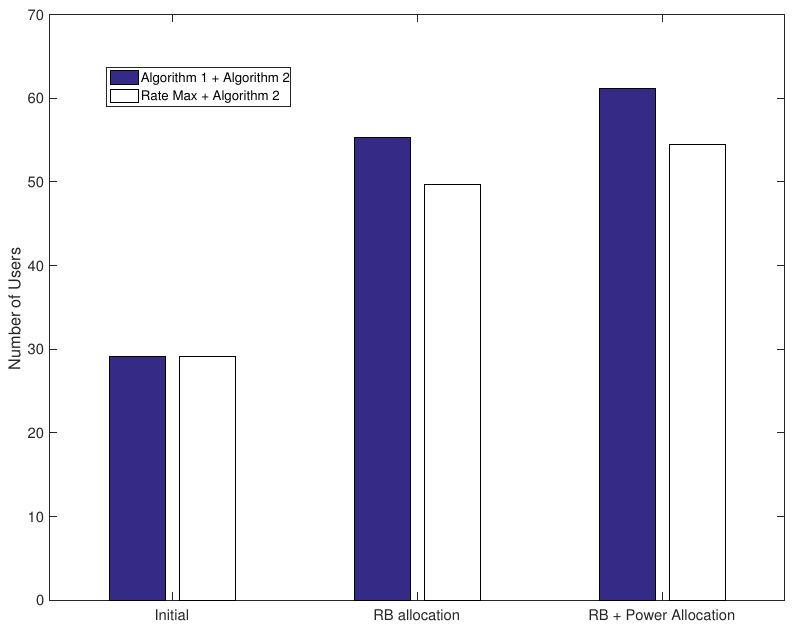
Figure 11. Average number of satisfied users (in terms of Signal to Interference and Noise Ratio (SINR) requirement) after each stage of the Resource Block (RB) and power allocation procedure.